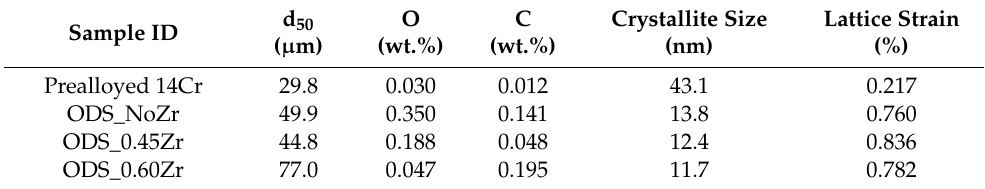
Table 2. Mean particle size, interstitial contents and crystallographic parameters of the powders.